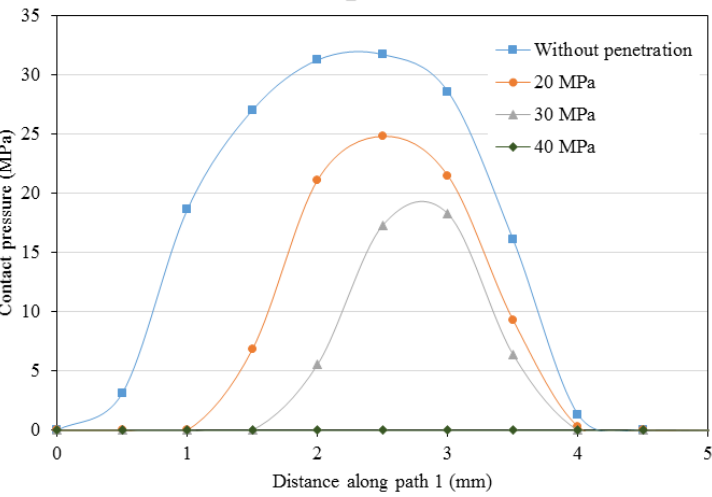
Figure 10. Contact pressure under different fluid pressure.